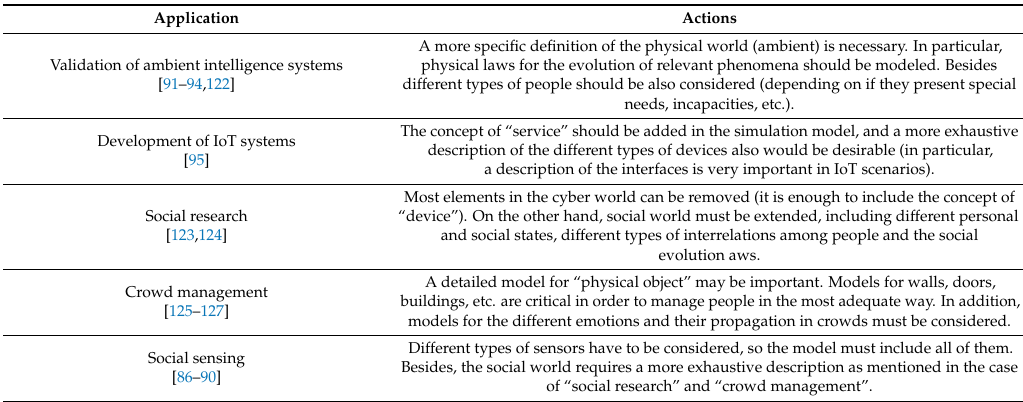
Table 7. Criteria for the creation of the simulation model.